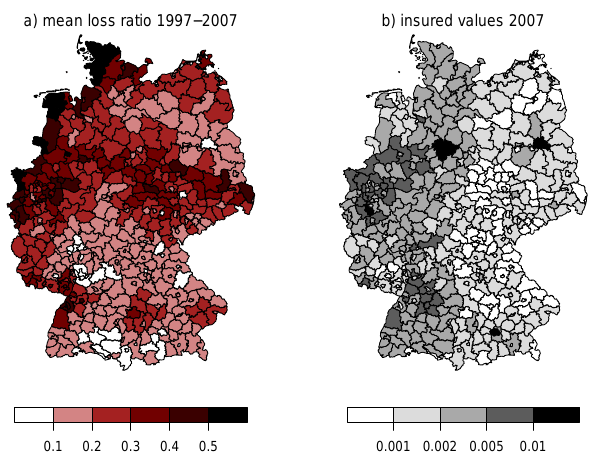
Fig. 3. Spatial distribution of the insurance loss data. (a) mean winter half year loss ratios (VGV, years 1997–2007), normalised with loss ratio sum of all 439 administrative districts (unit: %) (b) insured values for the year 2007, normalised with total sum of all 439 administrative